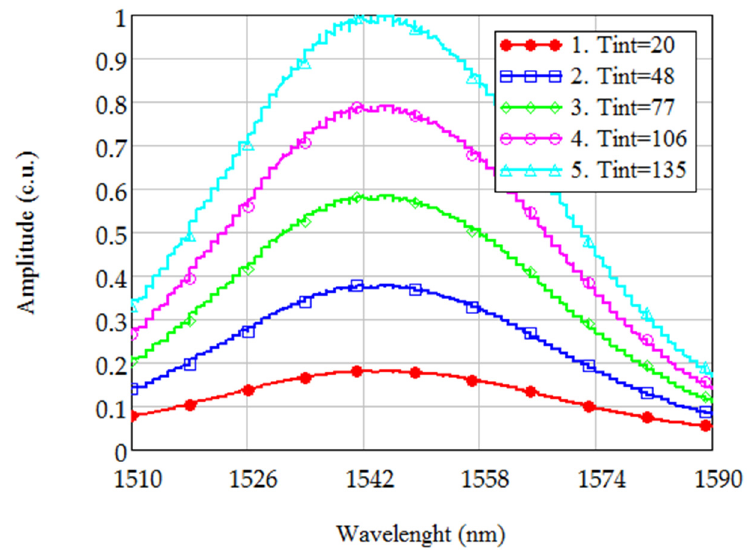
Figure 2. The broadband radiation spectra, obtained at different TINT values (1–20 ms, 2–48 ms, 3–77 ms, 4–106 ms, 5–135 ms).